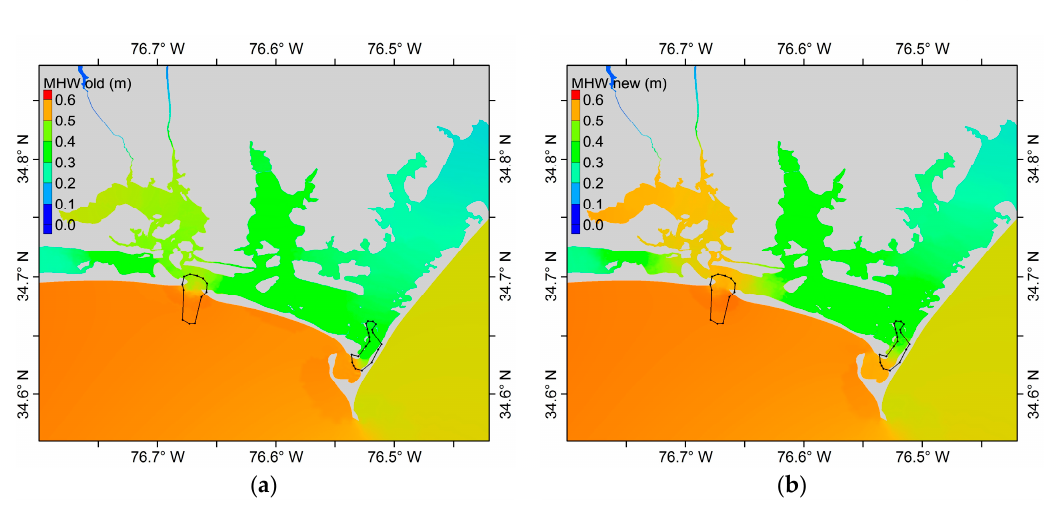
( d ) Figure 12. The MHW changes induced by the inlet morphological changes around Beaufort Inlet and Barden Inlet: ( a ) MHW from the old-bathy model; ( b ) MHW from the new-bathy model; ( c ) the MHW difference between the new-bathy model and the old-bathy model; ( d ) the MHW change in percentage relative to the old-bathy model MHW. The black dotted polygons delineate the area with changed bathymetry. The influence range of the morphological changes around Ocracoke Inlet, Hatteras Inlet, and Oregon Inlet are shorter than the distances between itself and its neighbor inlets. Thus, the morphological changes of these three inlets have independent effects on local tidal datum changes. For Ocracoke Inlet, water depths (Figure 4) have increased from ~4 m to ~9 m in the northeastern part of the ocean-side area of the inlet but have decreased from ~4 m to ~2 m in most sound-side areas of the inlet. As a result, MHW (Figure 13) has increased of ~20% from ~0.35 m to ~0.42 m in the middle of the inlet and the increased MHW is confined within the inlet. MHW has a sudden drop by ~20% from ~0.21 m to ~0.17 m on the northeastern side behind the inlet and the decreased MHW extends inside of Pamlico Sound. The percentage of the decreased MHW gradually drops to 10% about 6 km behind the inlet in the northeastern direction. Therefore the decreased water depths at the inside entrance play a key role in strengthening the tides within the inlet but weakening the tides behind the inlet.